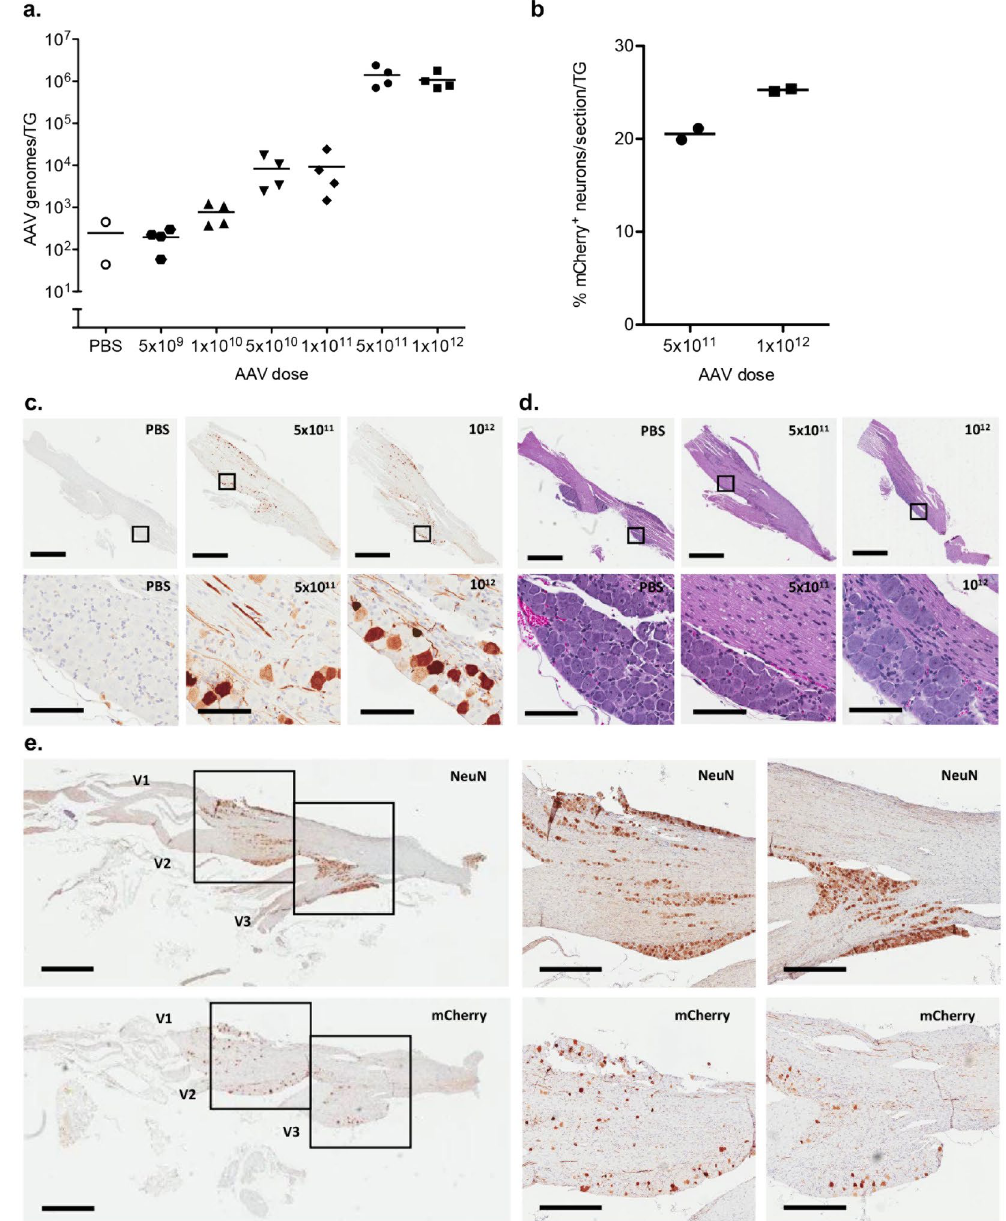
Figure 6. Dose optimization of scAAV1 gene delivery to trigeminal ganglia. Swiss Webster mice were inoculated by intradermal injection of the whiskerpad with PBS or increasing doses of scAAV1-smCBA- mCherry. At 6 weeks post AAV delivery trigeminal ganglia were analyzed for levels of vector genomes by qPCR ( a ). At the two highest doses the percentage of neurons positive for mCherry by immunohistochemistry were also determined ( b ). For qPCR each symbol represents one trigeminal ganglion (TG) from a total of either 2 animals for AAV1-treatment or 1 animal for PBS control for each dose. mCherry positive neurons were quantified using Cell Profiler software and each symbol represents the average number of mCherry positive neurons from 2 sections of one individual trigeminal ganglion (TG) from 1 animal for each dose. Representative sections stained by immunohistochemistry for mCherry ( c ) or with hematoxylin/eosin ( d ) are shown from PBS or scAAV1-smCBA-mCherry injected mice. Representative sections showing NeuN staining (Upper panel) or mCherry staining (Lower panel) in the V1 (Olfactory), V2 (Maxillary) and V3 (Mandibular) branches of the trigeminal ganglion are shown for animals that received 1 × 10 12 vector genomes of scAAV1-smCBA-mCherry ( e ). Scale bars for c / d : upper panels - 1 mm, lower panels - 100 μ m. Scale bars for e : left panel - 1 mm, right two panels - 500 μ